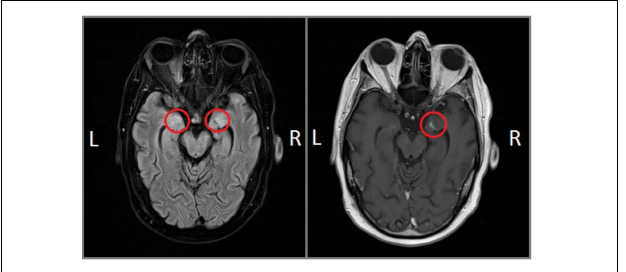
FIGURE 1 | FF’s MRI scans: FLAIR (left) and T1-weighted gadolinium-enhanced (right)